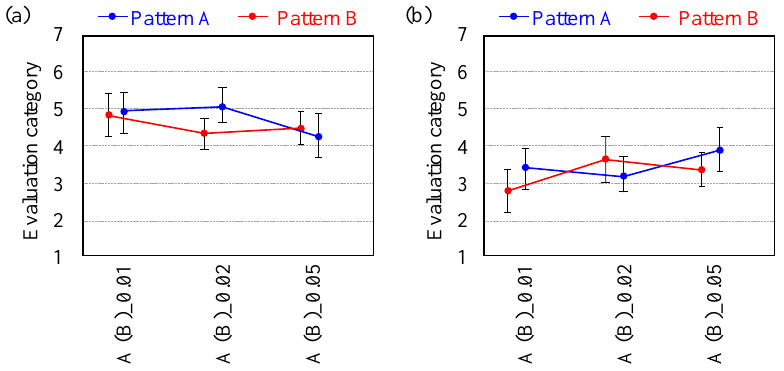
Table 7. List of warning sounds adopted for Phase 3 of the present study .